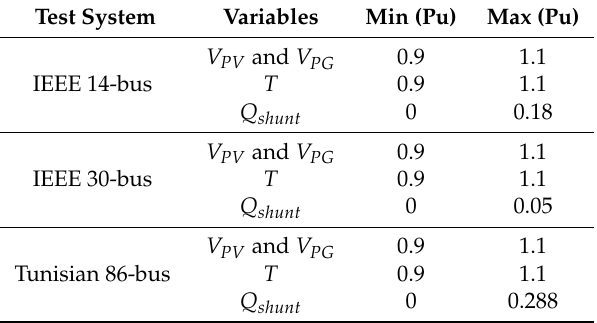
Table 2. Control variables limits for all power